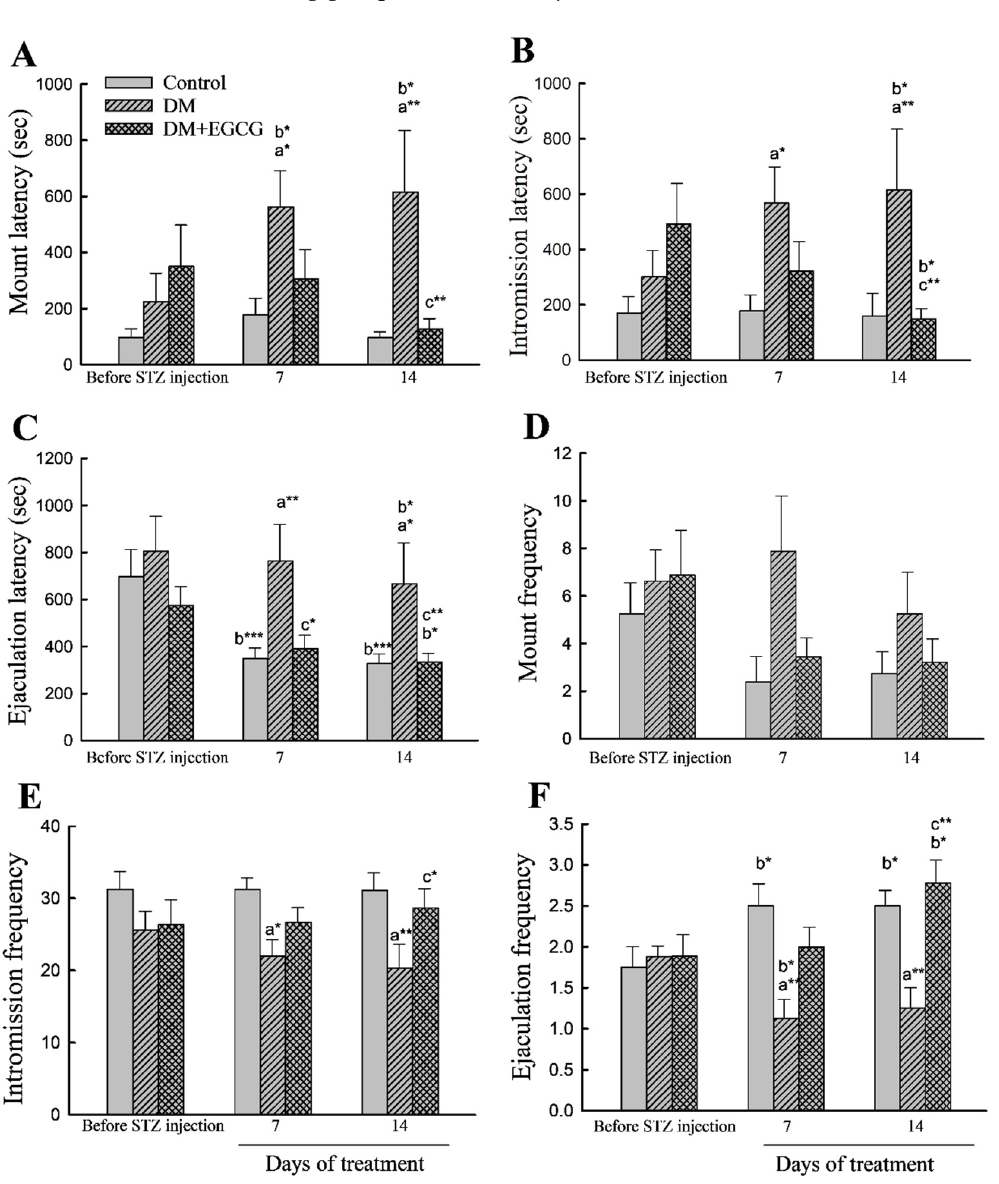
Figure 3. Sexual behavior parameters. ( A ) mount latency; ( B ) intromission latency; ( C ) ejaculation latency; ( D ) mount frequency; ( E ) intromission frequency; ( F ) ejaculation frequency. The data were expressed as mean ± SEM. *, p < 0.05; **, p < 0.01; ***, p < 0.001. (a), compared to the control group at the same time point (7 days or 14 days); (b), compared to the same group before STZ injection; (c), compared to the DM group at the same time point. DM, diabetes mellitus; EGCG , epigallocatechin gallate.